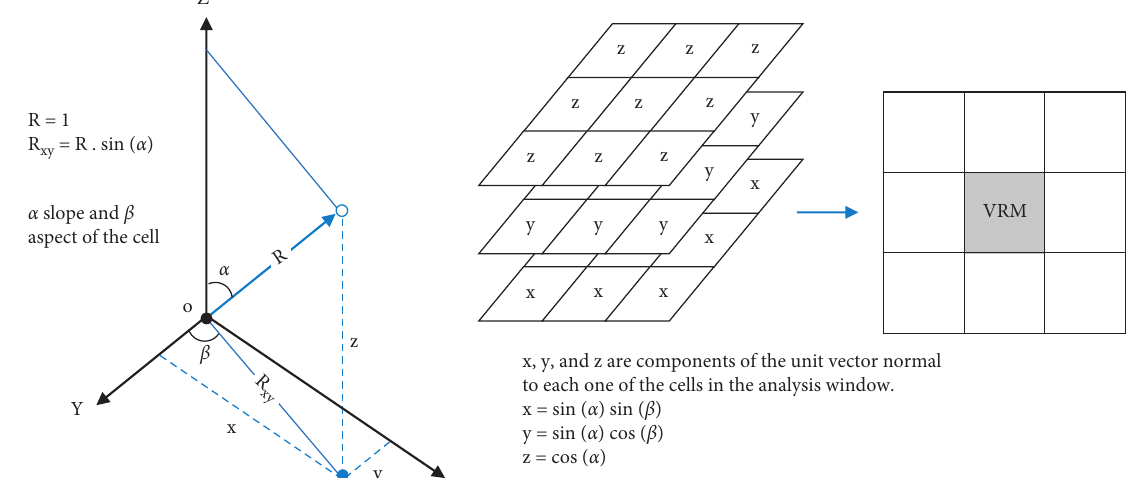
Figure 7: Computation of VRM utilizing vector analysis and a gridded DEM.